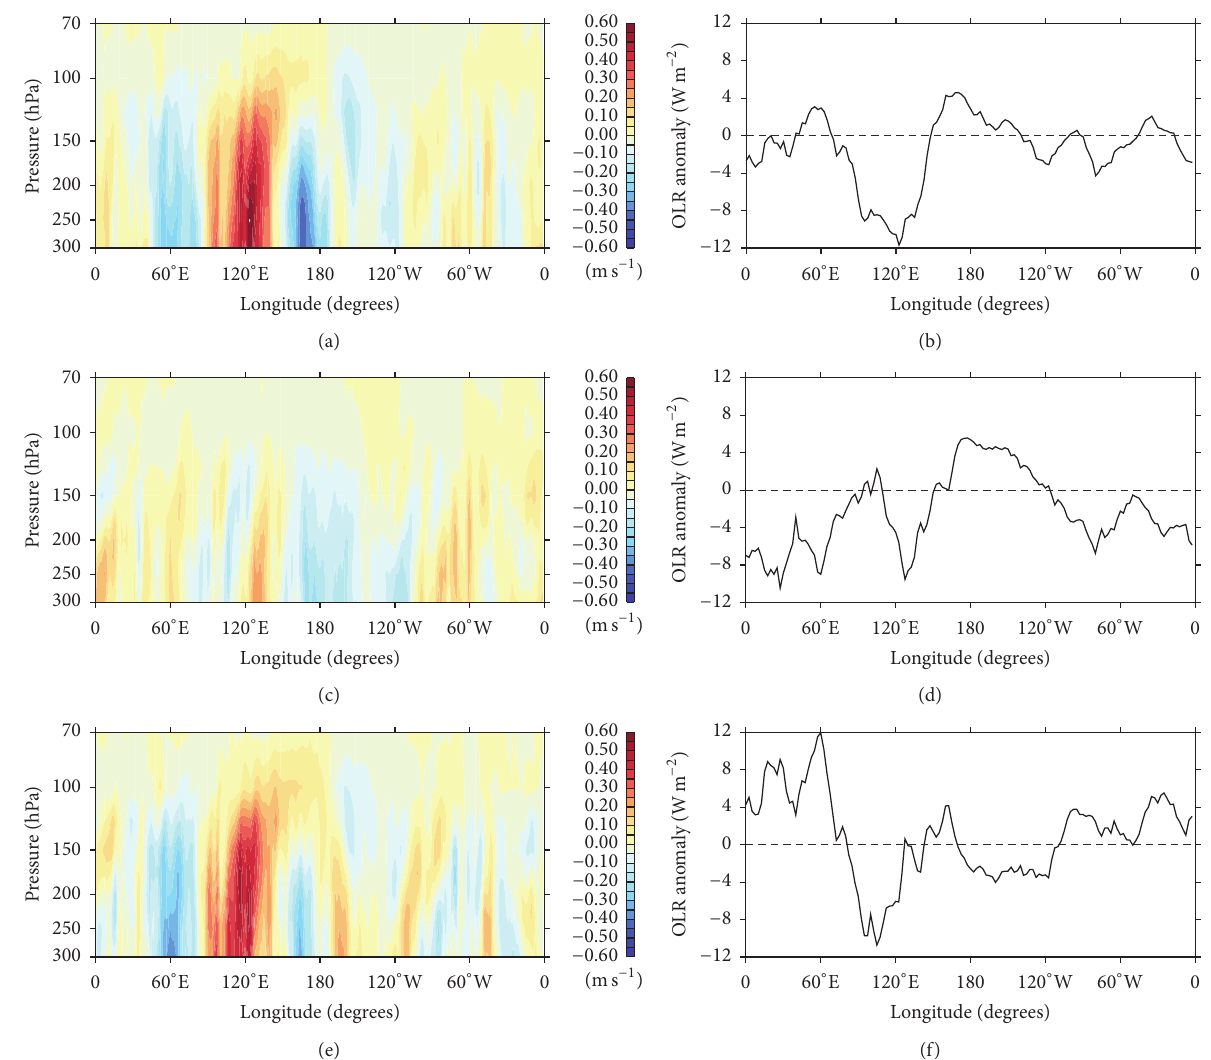
Figure 4: Longitude-pressure cross sections of tropical mean (20 ∘ N–20 ∘ S) vertical velocity anomalies (a and c) and meridional distributions of tropical mean OLR anomalies (b and d) during the “prewarming” (a and b) and “postwarming” (c and d) periods in 1999. (e and f) Same as Figure 2(c) but for vertical velocity anomalies (e) and OLR anomalies (f),